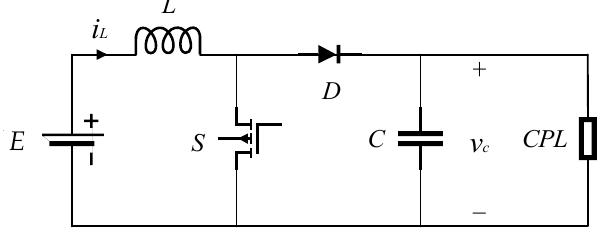
Figure 1. The circuit topology of DC/DC boost converter with CPL.